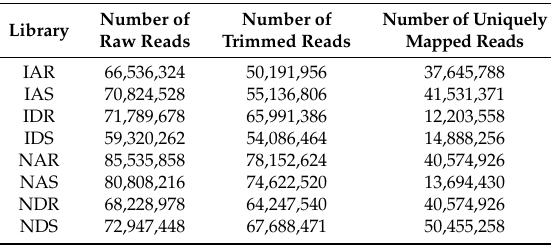
Table 1. Summary of trimming and read mapping results of the sequences generated from eight complementary DNA (cDNA) libraries of root (R) and shoot tissues (S) from two rice genotypes under optimal (A) and low nitrogen (D).